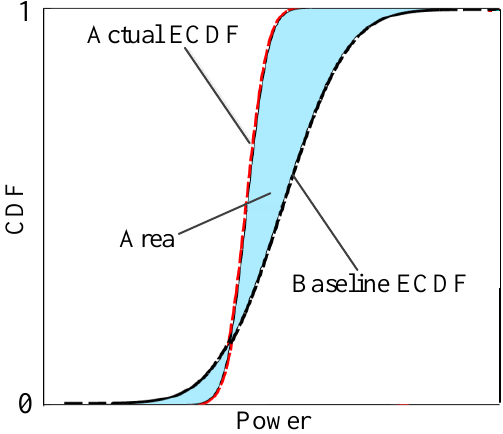
Figure 3. Illustration of probabilistic area metric.